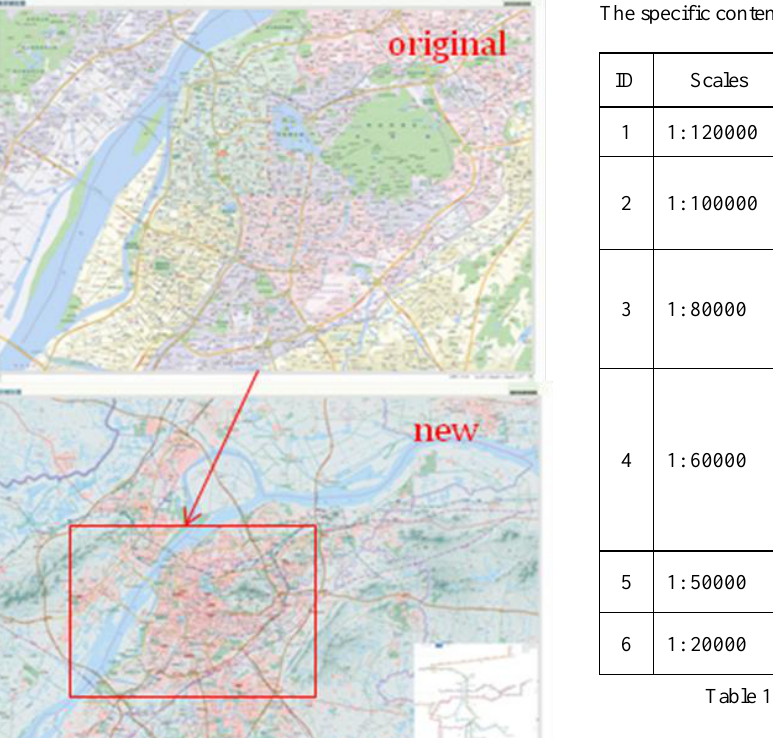
The each of city maps is represented in an open page except for Hongkong and Macao, which are merged in an open page.